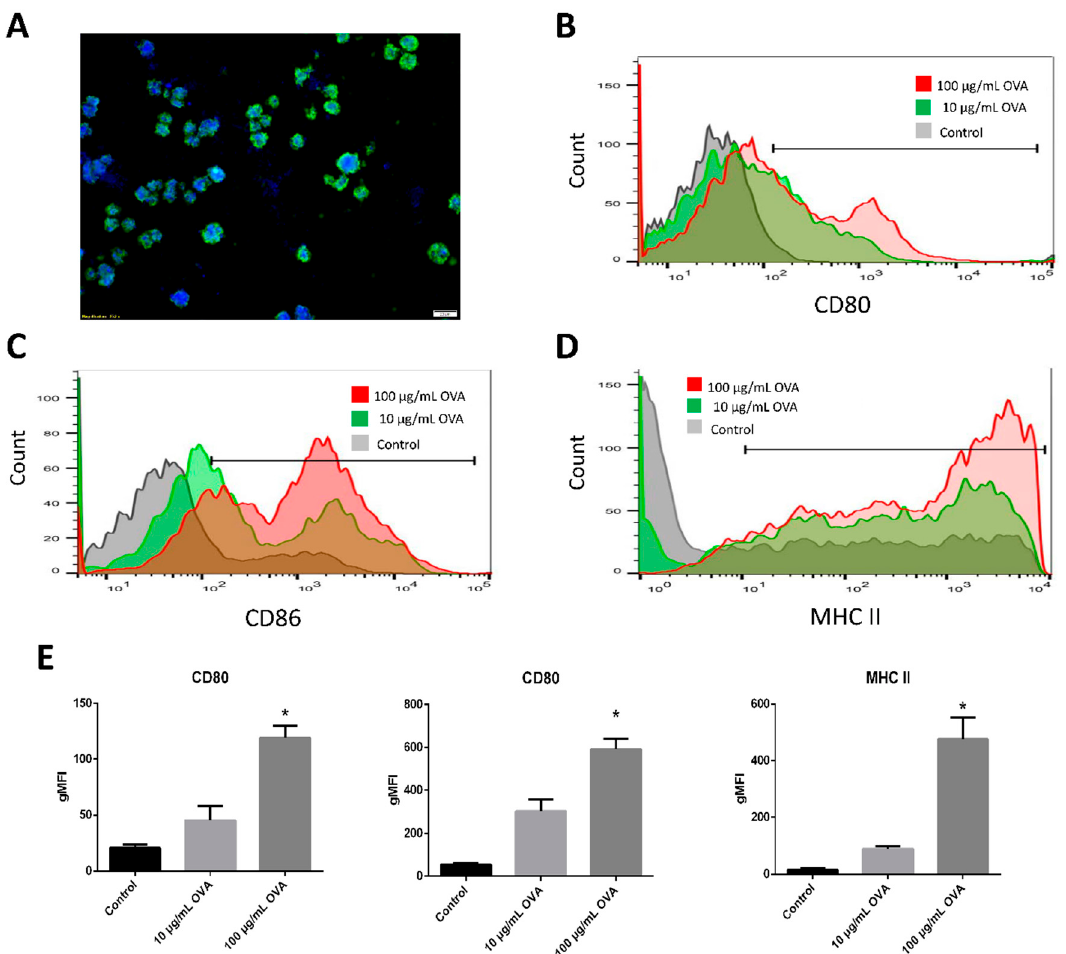
Figure 3. Recellularization of bone marrow dendritic cells (BMDCs) into decellularized lymph node (dLN) scaffolds. ( A ) Immunofluorescence staining with CD11c + BMDC in the dLN scaffolds. BMDCs were cultured inside dLN for 24 h with 100 or 10 µg/mL OVA antigen, and 100 µg/mL CPG-ODN stimulation. Flow cytometry was used to measure the expressions of ( B ) CD80, ( C ) CD86, and ( D ) major histocompatibility complex- ІІ (MHC- ІІ ). ( E ) The geometric mean fluorescence intensities (gMFIs) of CD80, CD86, and MHC- ІІ . (Data are presented as the mean ± SD, *: p < 0.01.).